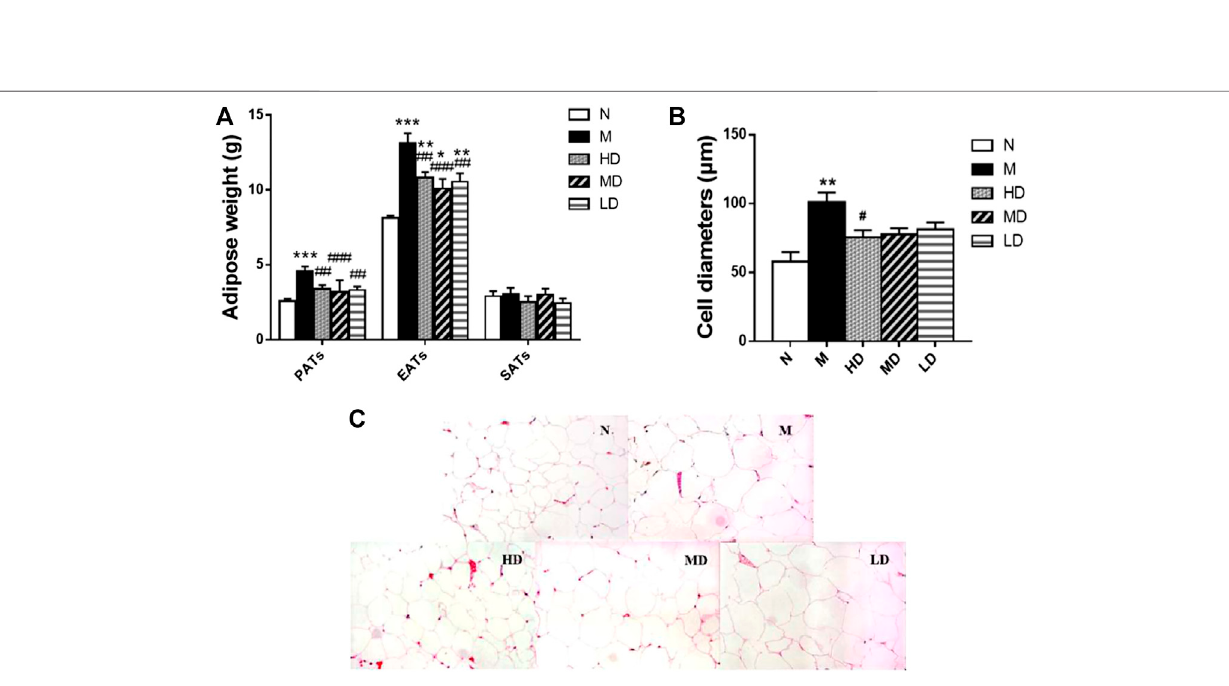
Frontiers in Pharmacology |